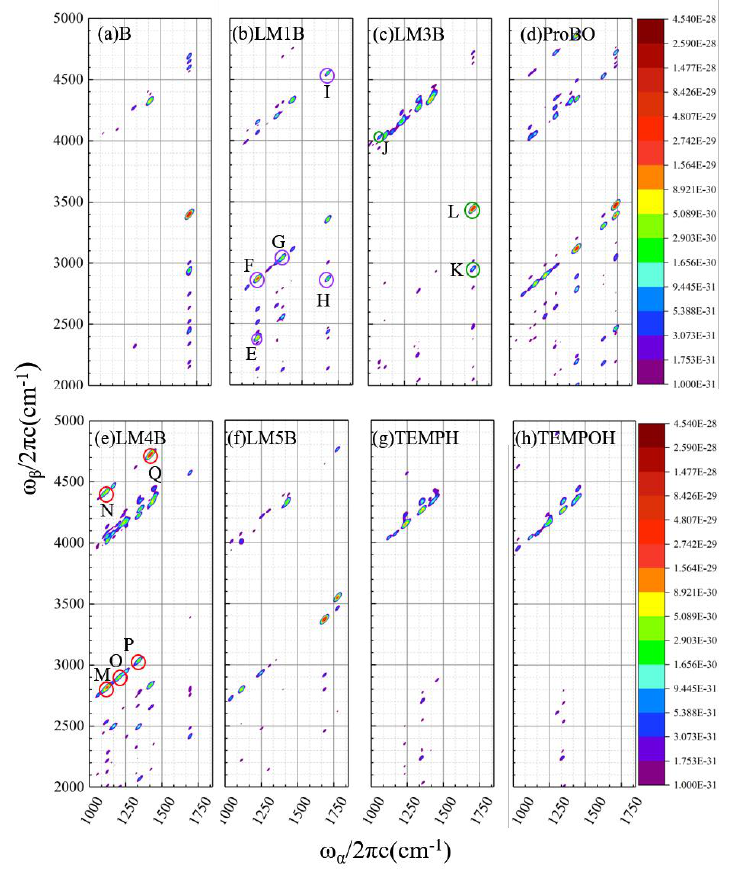
Figure 8. Calculated EVV-2DIR spectrum for ( a ) reactant imine molecule B, ( b ) enamine tautomer intermediate LM1B, ( c ) α -aminoxylated species intermediate LM3B, ( d ) α -amino-enones product ProBO, ( e ) α -aminoxylated enamine intermediate LM4B, ( f ) intermediate LM5B, ( g ) TEMPH and ( h ) TEMPOH in tautomerizable imine reaction pathway. The figure is shown as a contour map with a logarithmic scale. The characteristic cross peaks in the intermediate LM1B are indicated by labels and purple circles , in the α -aminoxylated intermediate LM3B are indicated by labels and green circles and in the α -aminoxylated intermediate LM4B are indicated by labels and red circles. Table 2. The vibrational mode pairs corresponding to the characteristic cross peaks in the enamine tautomer LM1B and their respective contributions.